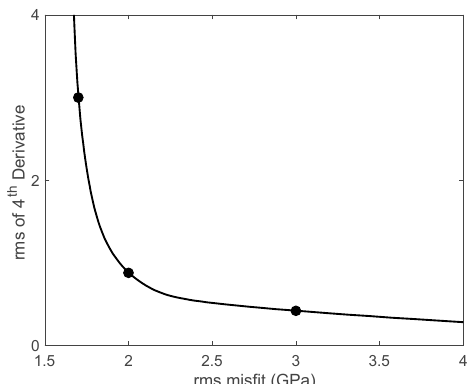
Figure 3. Tradeoff between root-mean-square (rms) data misfit and model smoothness as measured by the root-mean-square average of the fourth derivative of Helmholtz energy. The line defines the locus of solutions obtained by varying the damping factor for regularization. Circles mark points with rms misfits of 1.7 GPa, 2 GPa, and 3 GPa that are associated with fits listed in Table 3.